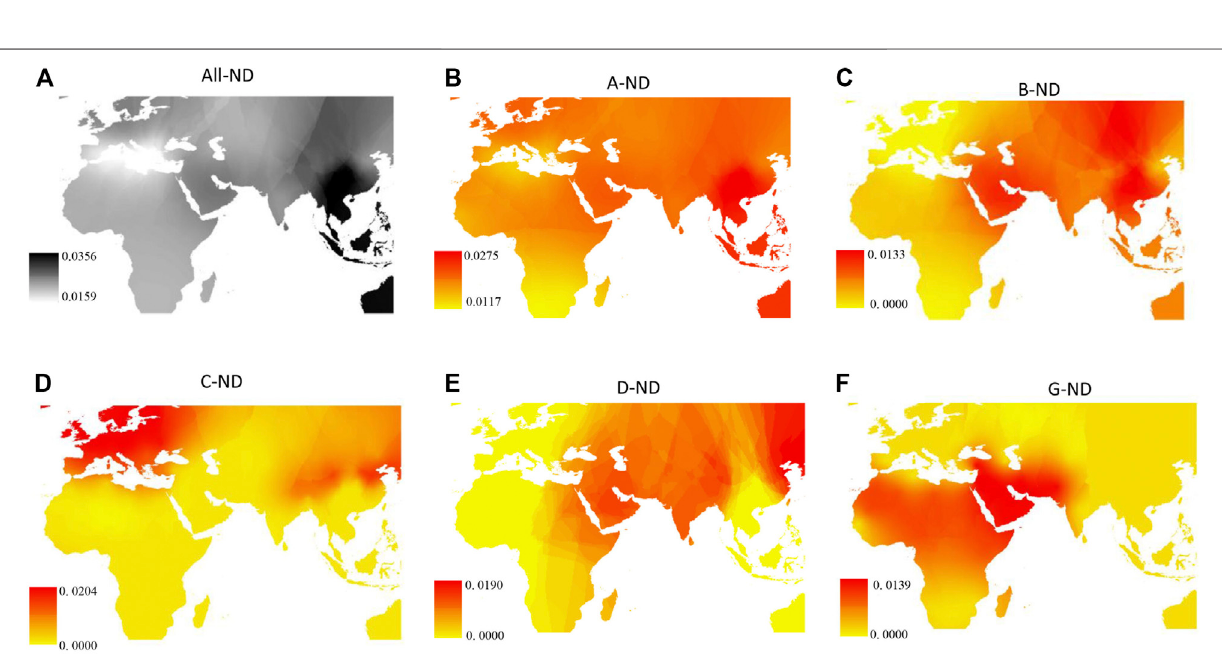
Frontiers in Genetics |